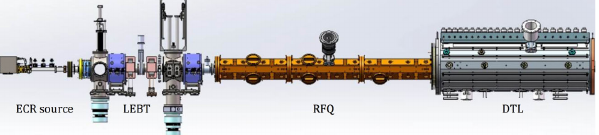
FIG. 1. 7 MeV H − linac injector for the synchrotron of the Xi ’ an 200 MeV Proton Application Facility.